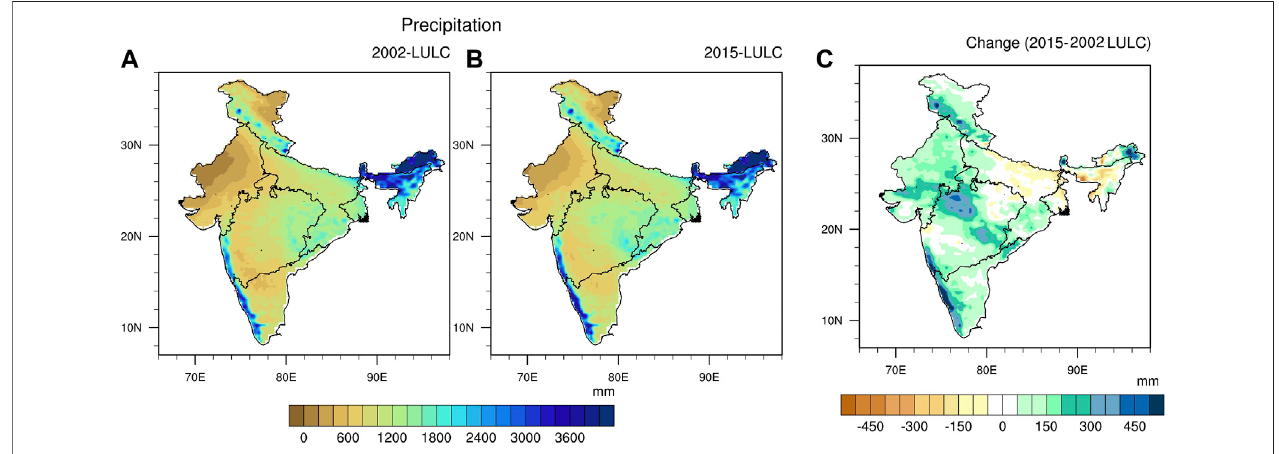
FIGURE 8 | Simulated precipitation data of (A) 2002 LULC, (B) 2015 LULC, and (C) major changes in precipitation due to LULCC during 2002 –